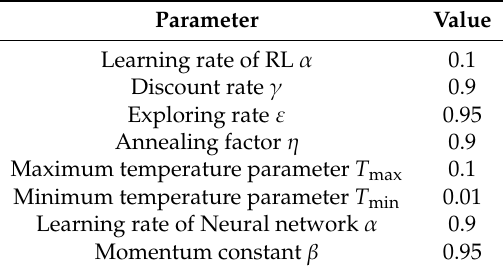
Table 2. Experimental